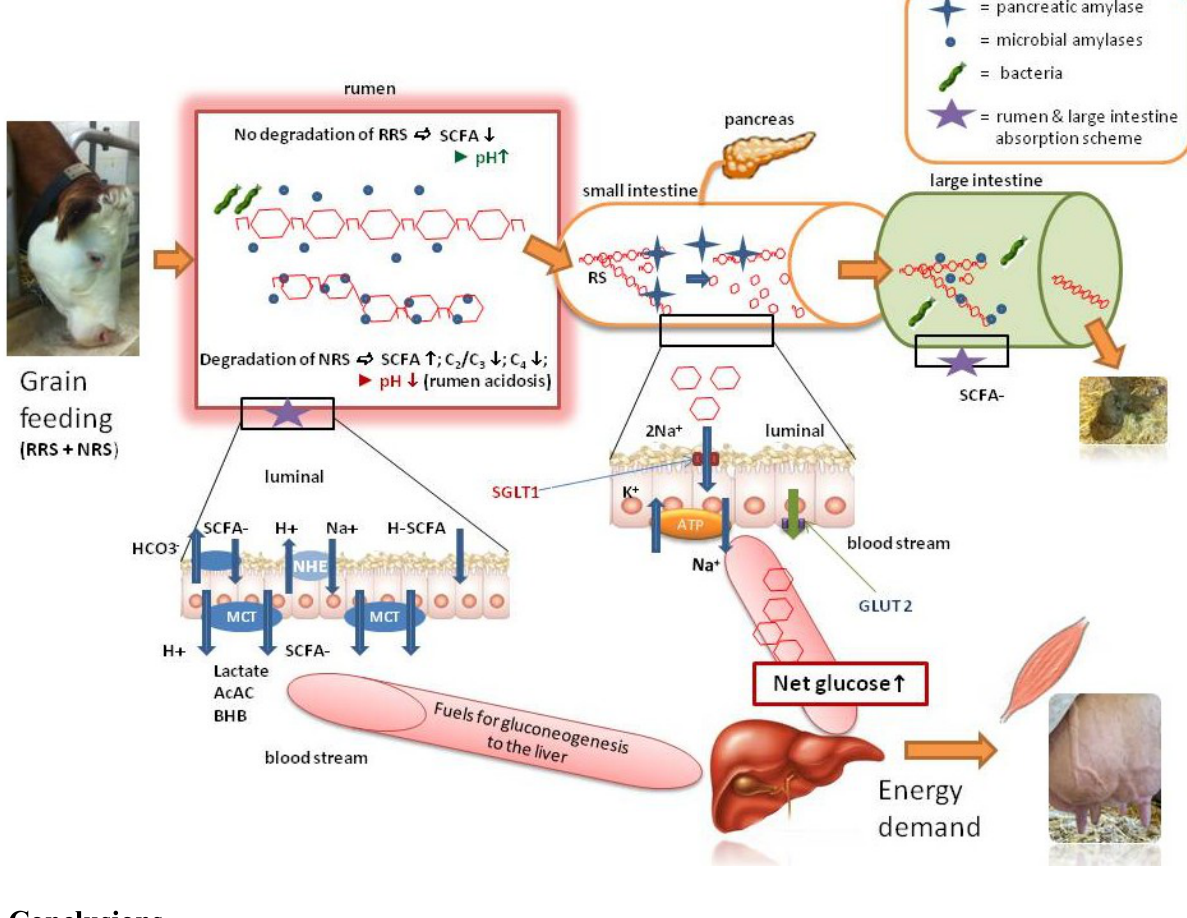
Figure 2. A simplified model describing the fates of ruminally resistant starch (RRS) and non-RRS (NRS) fed to cattle. The RRS is not digested in the rumen, which results in low concentrations of short-chain fatty acids (SCFA) and a higher ruminal pH. NRS is degraded in the rumen and leads to a release of SCFA, changing the proportions of acetate (C propionate (C ) and butyrate (C ), as well as decreasing the ruminal pH (high risk of rumen 3 4 acidosis). The undigested RRS is mostly degraded in the small intestine by pancreatic amylases, some portions of it can be degraded in the large intestine. The model also indicates the mechanisms of removal of SCFA (metabolism of SCFA to beta-hydroxybutyrate (BHB), acetoacetate (AcAc), and lactate) from the rumen and the absorption of glucose from the small